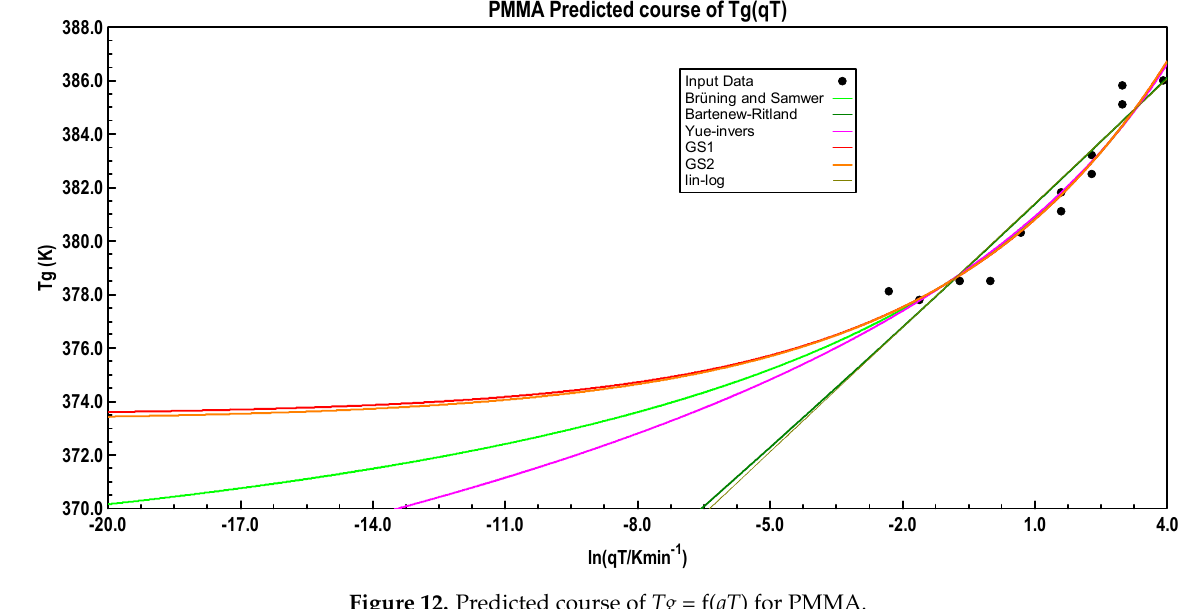
Figure 12. Predicted course of Tg = f(qT) for PMMA. The results of Schawe for PS are depicted in Figure 13.